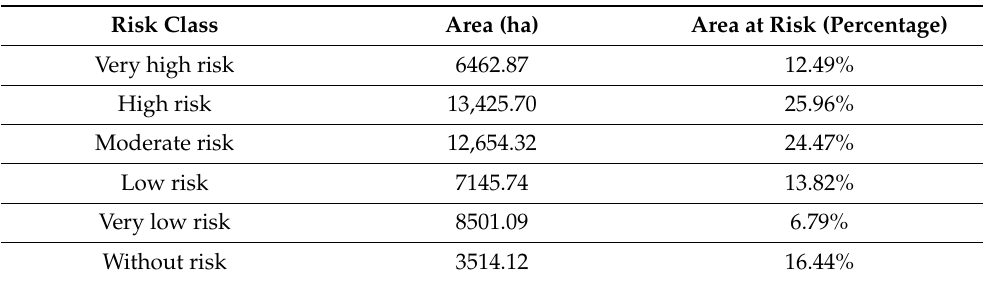
Figure 10. Soil degradation risk map of the ULB, showing the spatial variation of degradation risk, developed based on the aggregation of the selected criteria using the computed weights (see Figure 4 and Table 5). Table 7. Percentage of soil degradation areas in ULB computed from the soil degradation risk map presented in Figure